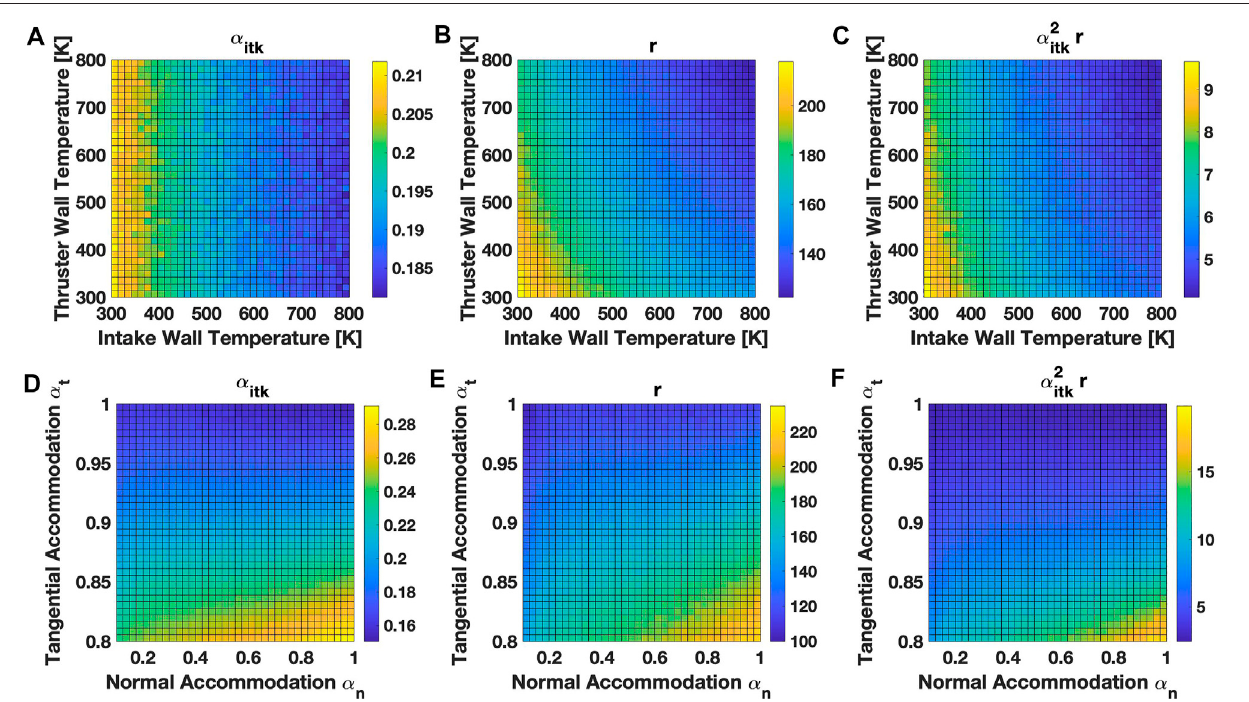
Figure resolution: 37 × 37 simulations. Simulated particles for each simulation: 1e5.